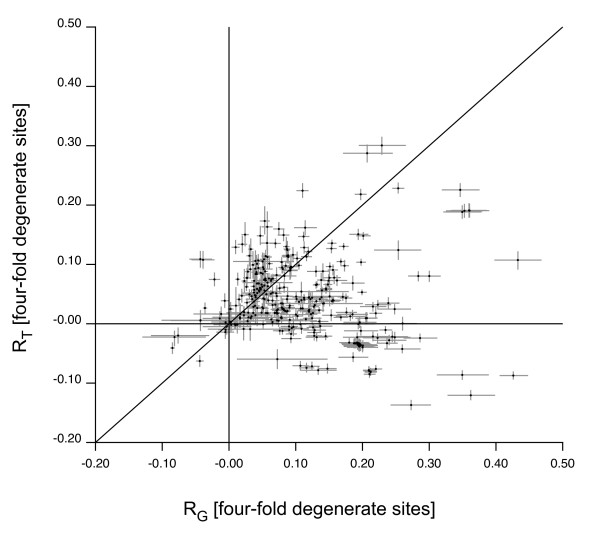
Strand asymmetry across bacterial chromosomes. A scatter plot of RT and RG for D4 sites on the leading strands of the 352 bacterial chromosomes. The values represent the average effect for the two leading strands in each of the replication arms, with the bars indicating the 95% uncertainty. The straight line represents RT = RG.